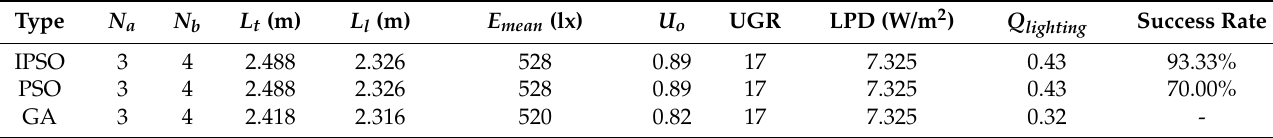
Table 6. Comparison of optimal results of different algorithms.